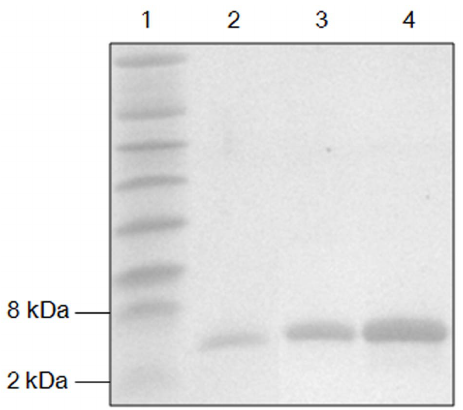
Figure 2. Tricine-SDS-PAGE of mature bovicin HJ50-like lantibiotics. Lane 1, protein marker; lane 2, perecin; lane 3, cerecin; lane 4, thuricin.